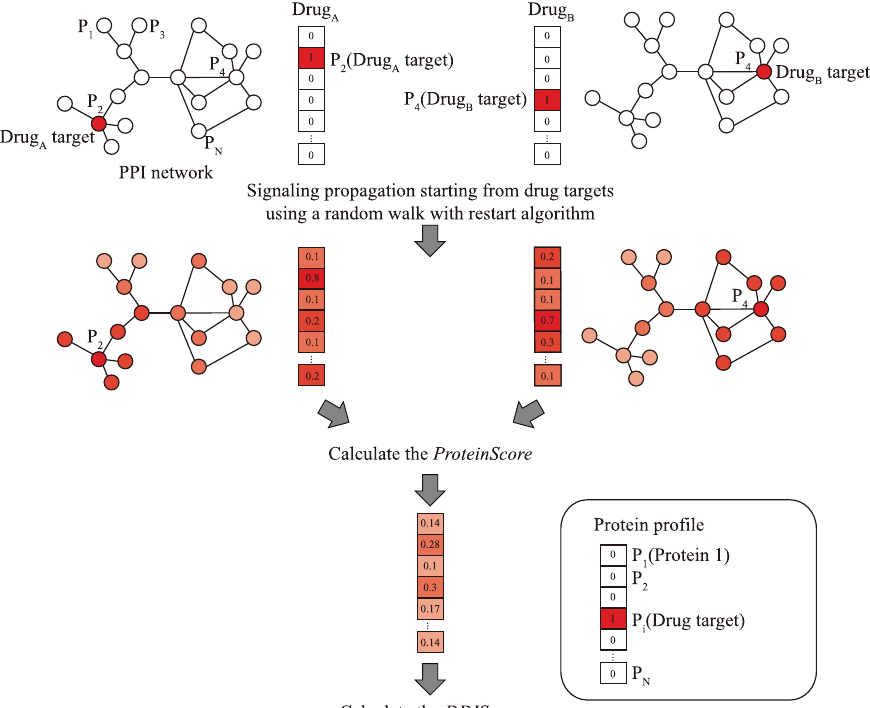
Fig 1. Overview of the algorithm for predicting PD DDIs. The signaling propagation starting from drug targets (Drug A : Protein 2 and Drug B : Protein 4) through the PPI network is simulated by RWR algorithm. The ProteinScore is defined as the values of the protein profile of drug pairs after finishing the simulation of RWR algorithm. The DDIScore is calculated by the summation of the ProteinScore of all proteins. The DDIScore represents the interference of signaling propagation through PPI network between drugs.